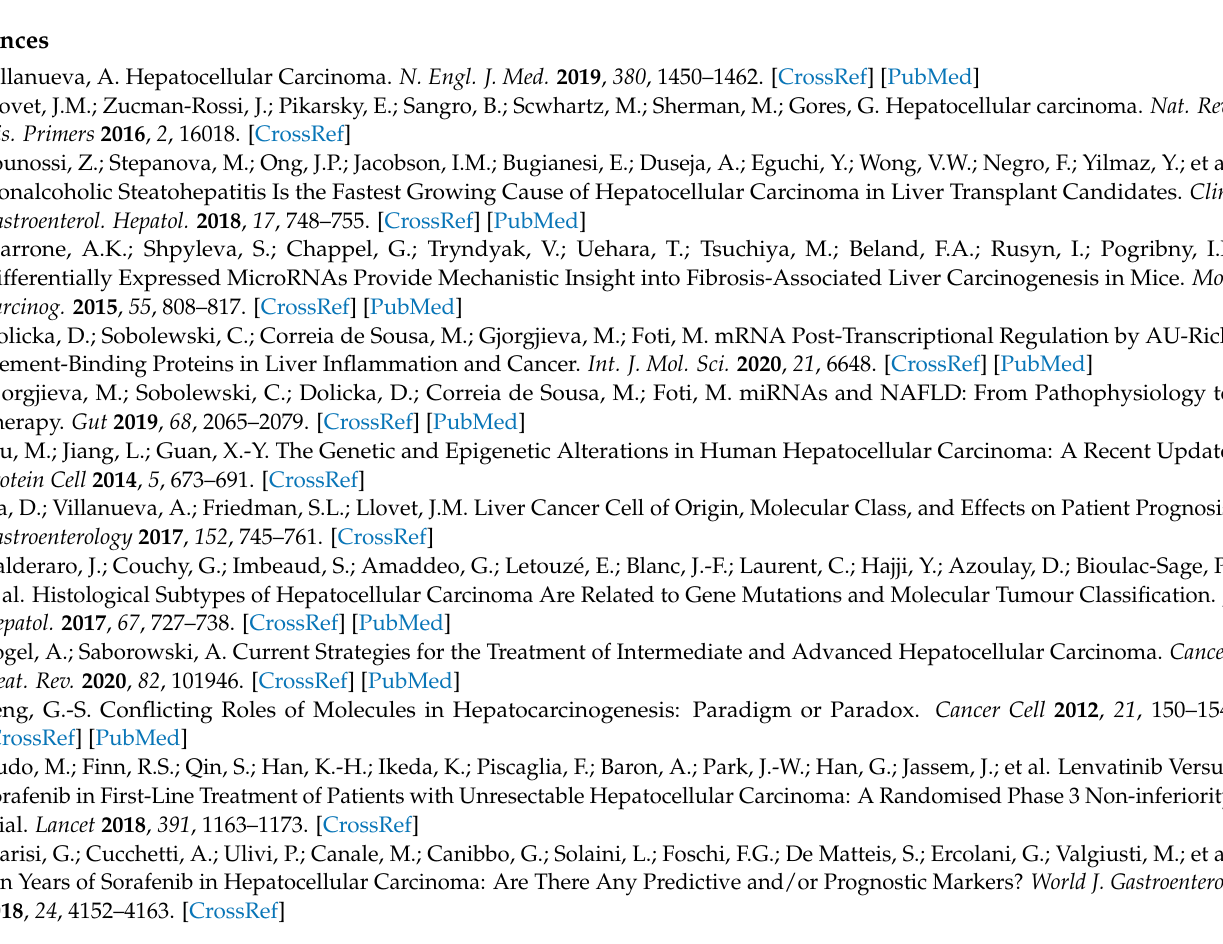
tumoral tissues from patients diagnosed with HCC, Table S1: List of primers used and respective sequences, Table S2: List of antibodies used and respective references, Table S3: miR-21 loss promotes the hepatic deregulation of both ONCs, Ds, and TSs. Table S4: miR-21 loss also promotes hepatic deregulation of other genes that modulate metabolic and inflammatory